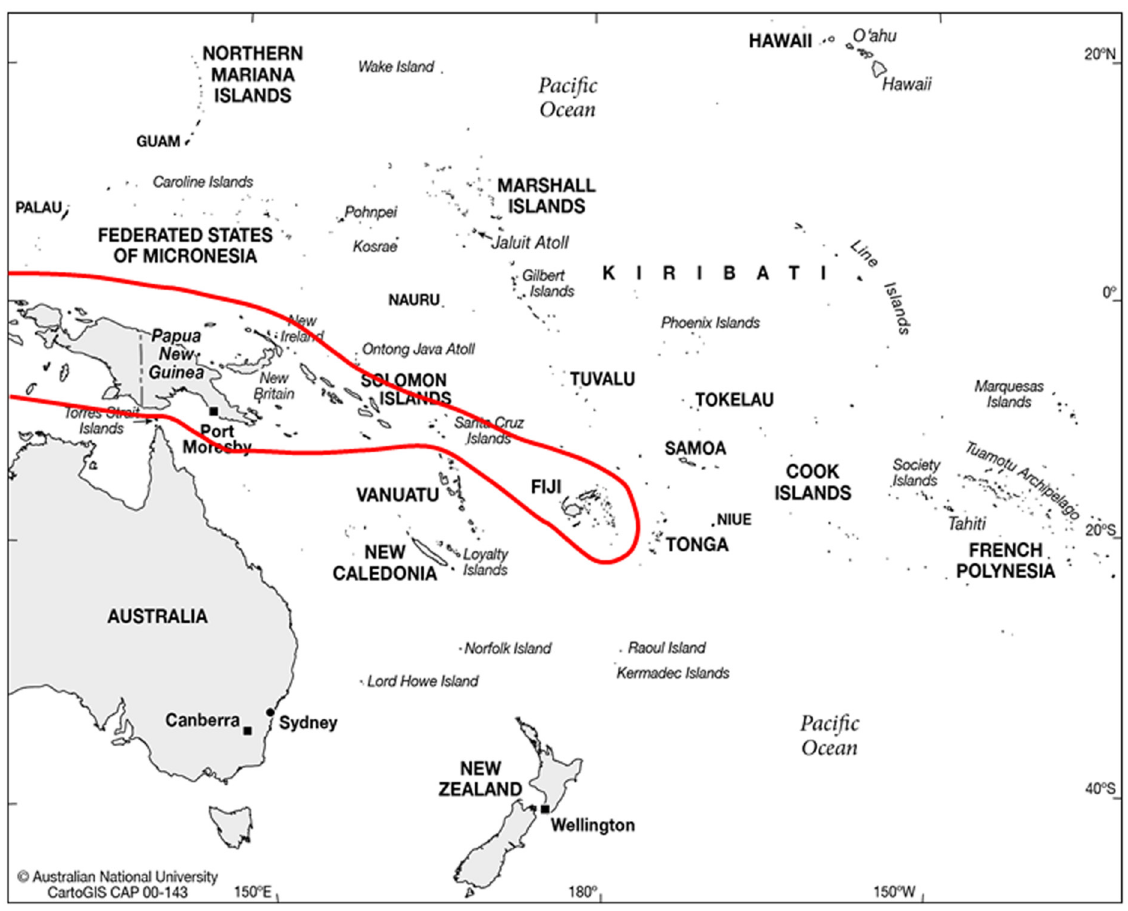
Fig. 9. Regional distribution of the genus Drepananthus (Annonaceae) in the Pacific. Base map sourced from CartoGIS, College of Asia and the Pacific, The Australian National University,